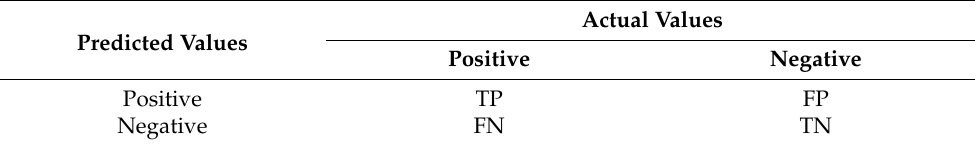
Table 2. The confusion